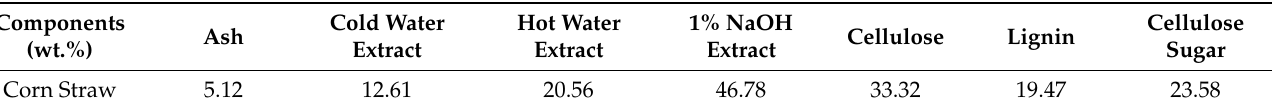
Table 3. Main components of siliceous